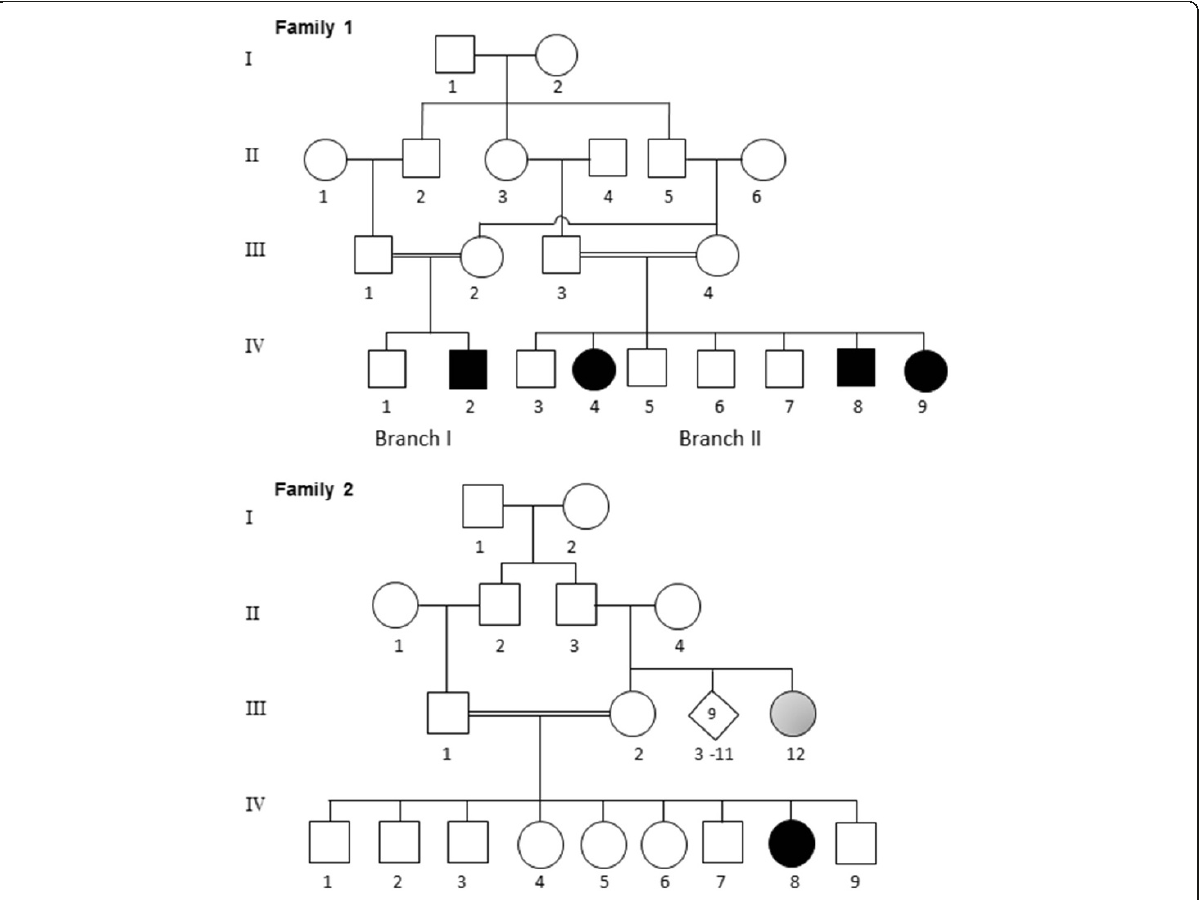
Figure 1 Pedigrees of the consanguineous Emirati families of Omani origins. Both families display typical recessive modes of inheritance. Double bar represents consanguinity; diamond represents several siblings of varying sex. Affected members are represented by filled symbols and the gray symbol as possibly affected